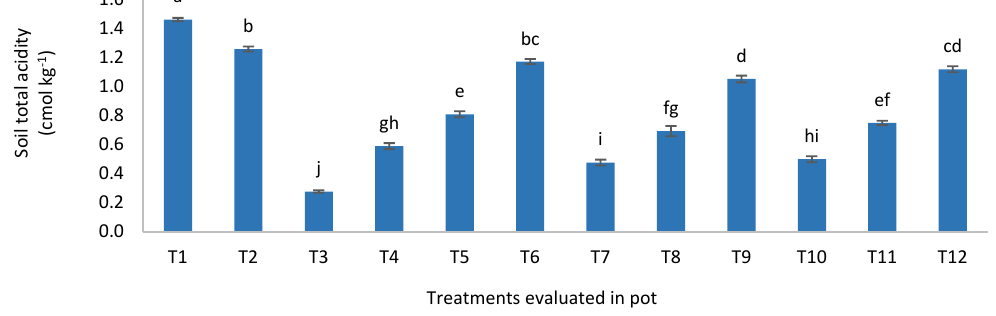
Figure 12. E ff ects of treatments on soil total acidity. Di ff erent letters indicate significant di ff erence Figure 12. Effects of treatments on soil total acidity. Different letters indicate significant difference between means using Tukey’s HSD (Honestly Significant Di ff erence) test at p ≤ 0.05. The error bars are between means using Tukey’s HSD (Honestly Significant Difference) test at p ≤ 0.05. The error bars the ± standard error of are the ± standard error of triplicates.